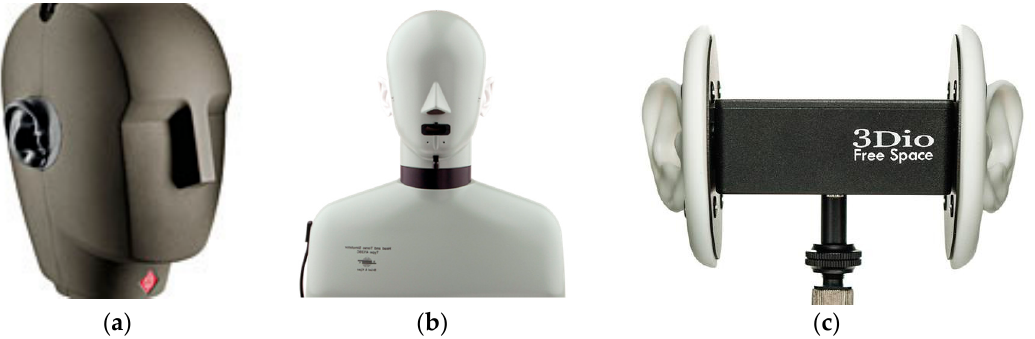
Figure 1. Binaural recording packages. ( a ) dummy head: Neumann KU-100; ( b ) head-and-torso simulator (HATS): Brüel & Kjær 4128D/C; ( c ) binaural microphones: 3Dio Free Space.